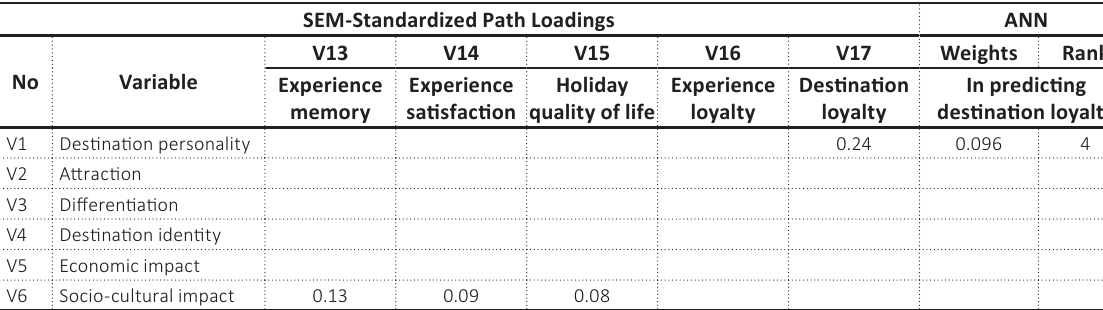
Table 6. Standardized path loadings of the hypotheses